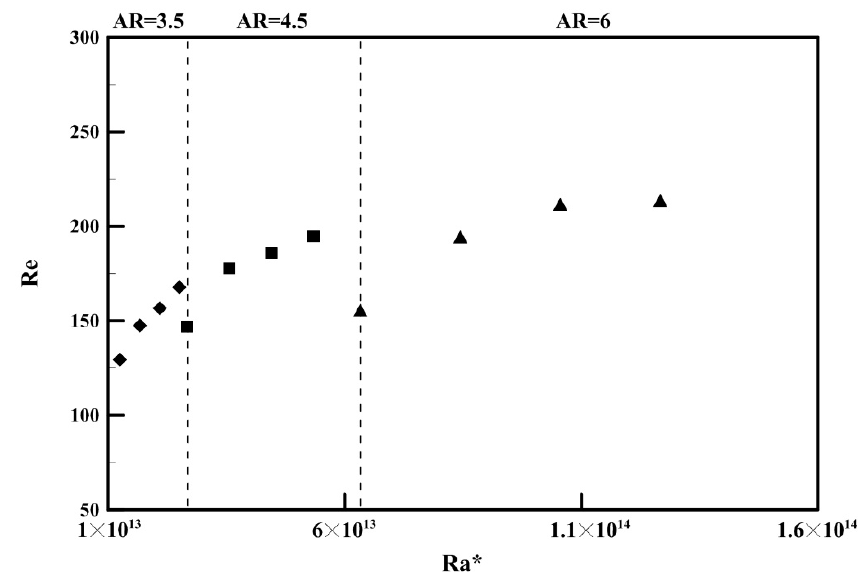
Figure 5. Relationship between the Reynolds number ( Re ) and the modified Rayleigh number ( Ra *).